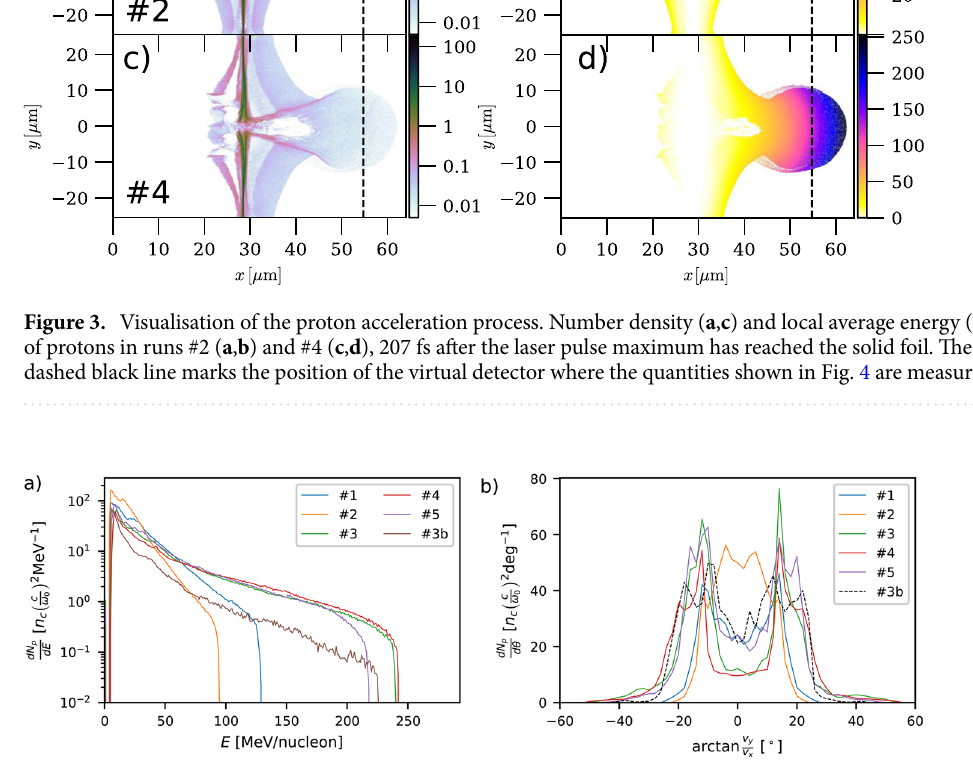
Figure 4. Properties of accelerated protons from 2D PIC simulations. ( a ) Energy and ( b ) angular spectra of protons tracked at the virtual detector, 26.2 µ m behind the target [marked by the vertical dashed line in all the panels of Fig.